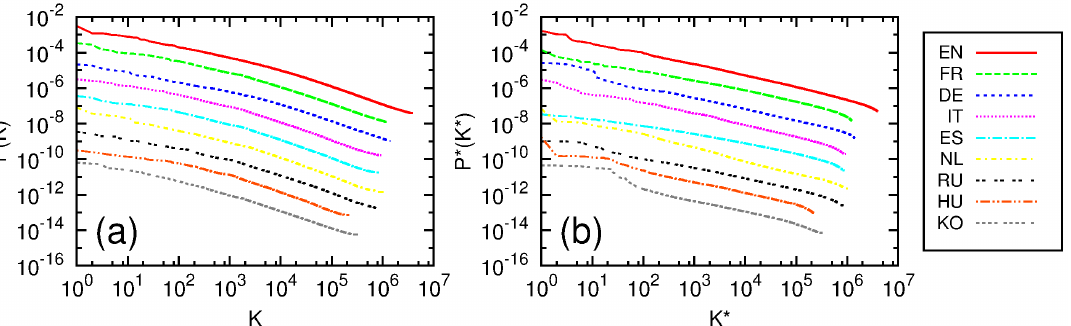
Figure 1. PageRank probability P ( K ) as function of PageRank index K (a) and CheiRank probability P (cid:2) ( K (cid:2) ) as function of CheiRank index K (cid:2) (b). For a better visualization each PageRank P and CheiRank P (cid:2) curve is shifted down by a factor 10 0 (EN), 10 1 (FR), 10 2 (DE), 10 3 (IT), 10 4